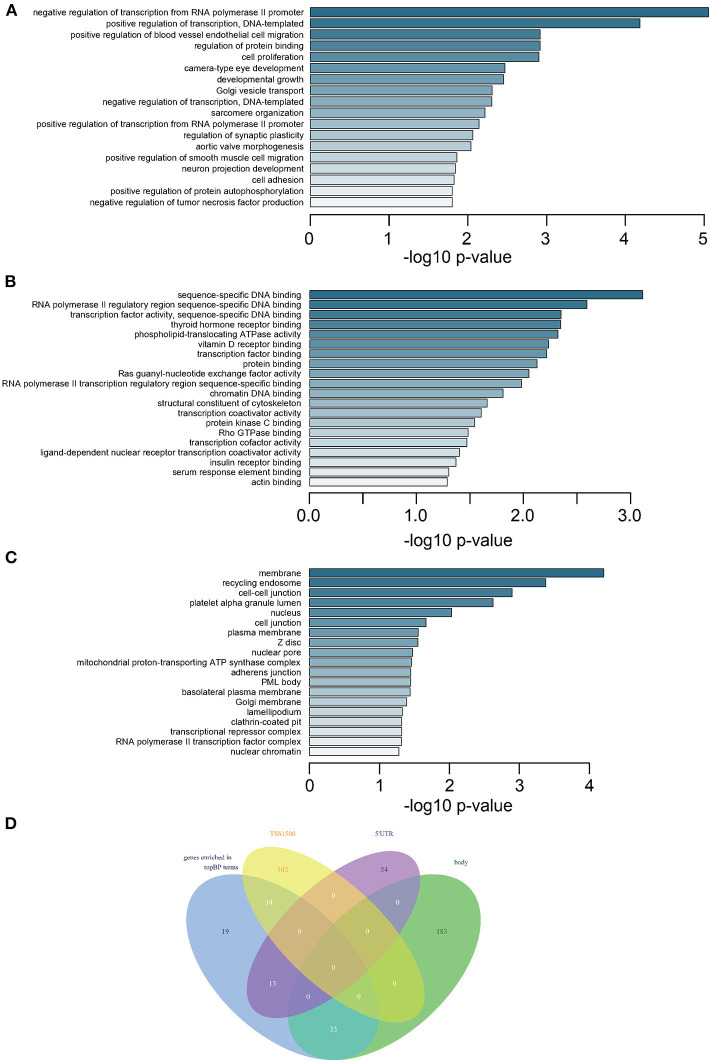
Enrichment analysis of DMGs and intersection of methylated CpGs in different regions. (A) Subontology of biological process (BP). (B) Subontology of molecular function (MF). (C) Subontology of cellular components (CC). (A–C) The x-axis indicates the log p-value. The y-axis is the enriched terms. (D) Venn plot for DMGs under BP terms based on different CpG methylation regions. The numbers on the diagram represent the DMG numbers in a specific region or multiple regions. The regions is as indicated.